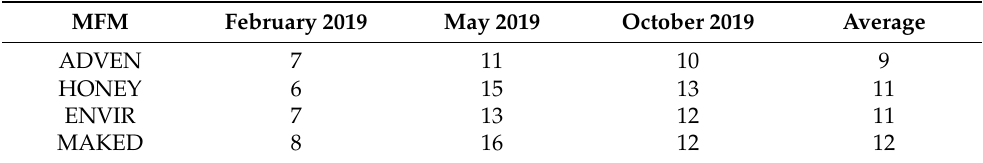
Table 3. Number of different morphospecies appearing in each type of margin on the studied farms at the three sampling dates and on average.